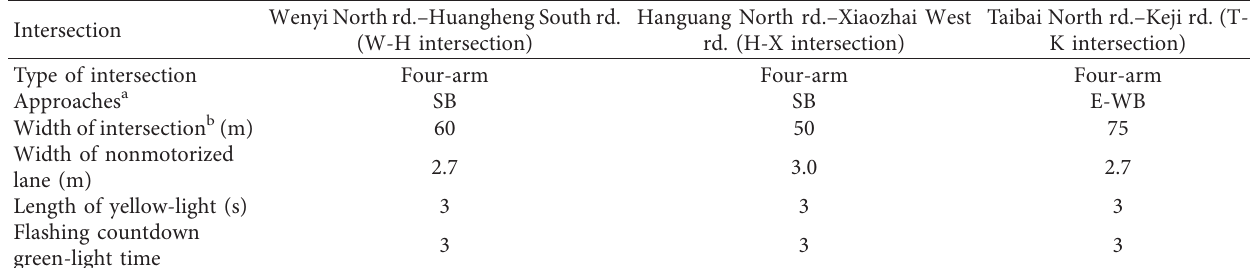
Table 1: Characteristics of study intersections.